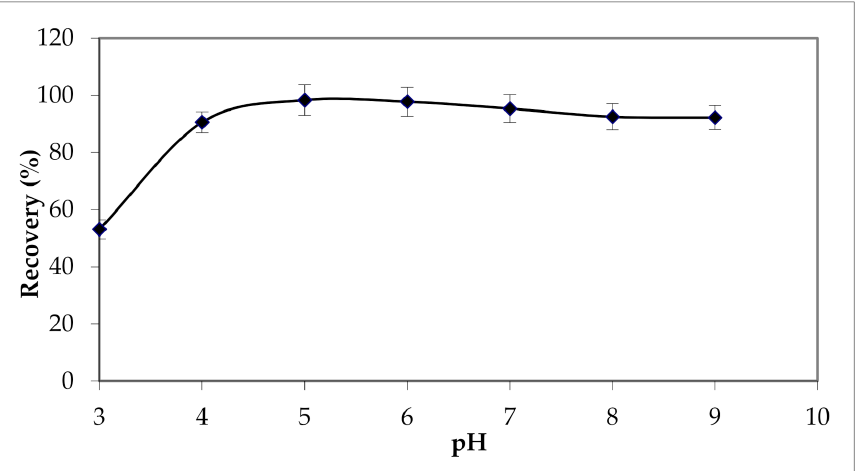
Figure 11. Effect of the sample pH on solid-phase extraction of Cu (II). Solvent volume = 12 mL; [HNO 3 ] = 2 M; the elution flow rate = 2 mL min − 1 ; sample volume = 100 mL; percolation flow rate = 2 mL min − 1